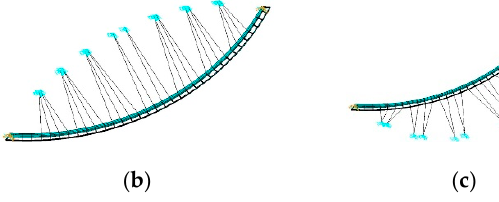
Figure 14. Cases of stay cable layout scheme. ( a ) Stayed cable case 1, ( b ) Stayed cable case 2, ( c ) Stayed cable case 3, ( d ) Stayed cable case 4.